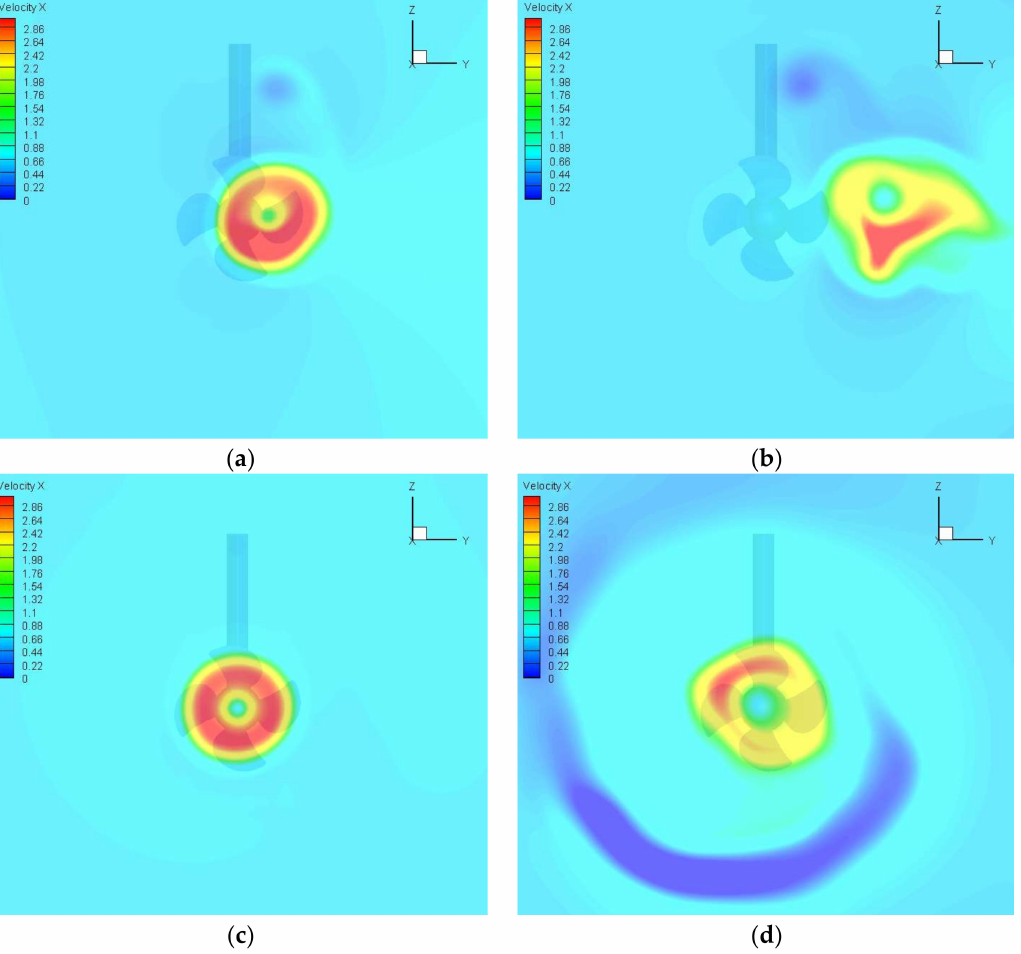
Figure 21. Velocity X in the transverse section ( J = 0.2): ( a ) x/D = 1.6 maneuvering condition; ( b ) x/D = 3.2 maneuvering condition; ( c ) x/D = 1.6 steady-state conditions; ( d ) x/D = 3.2 steady-state